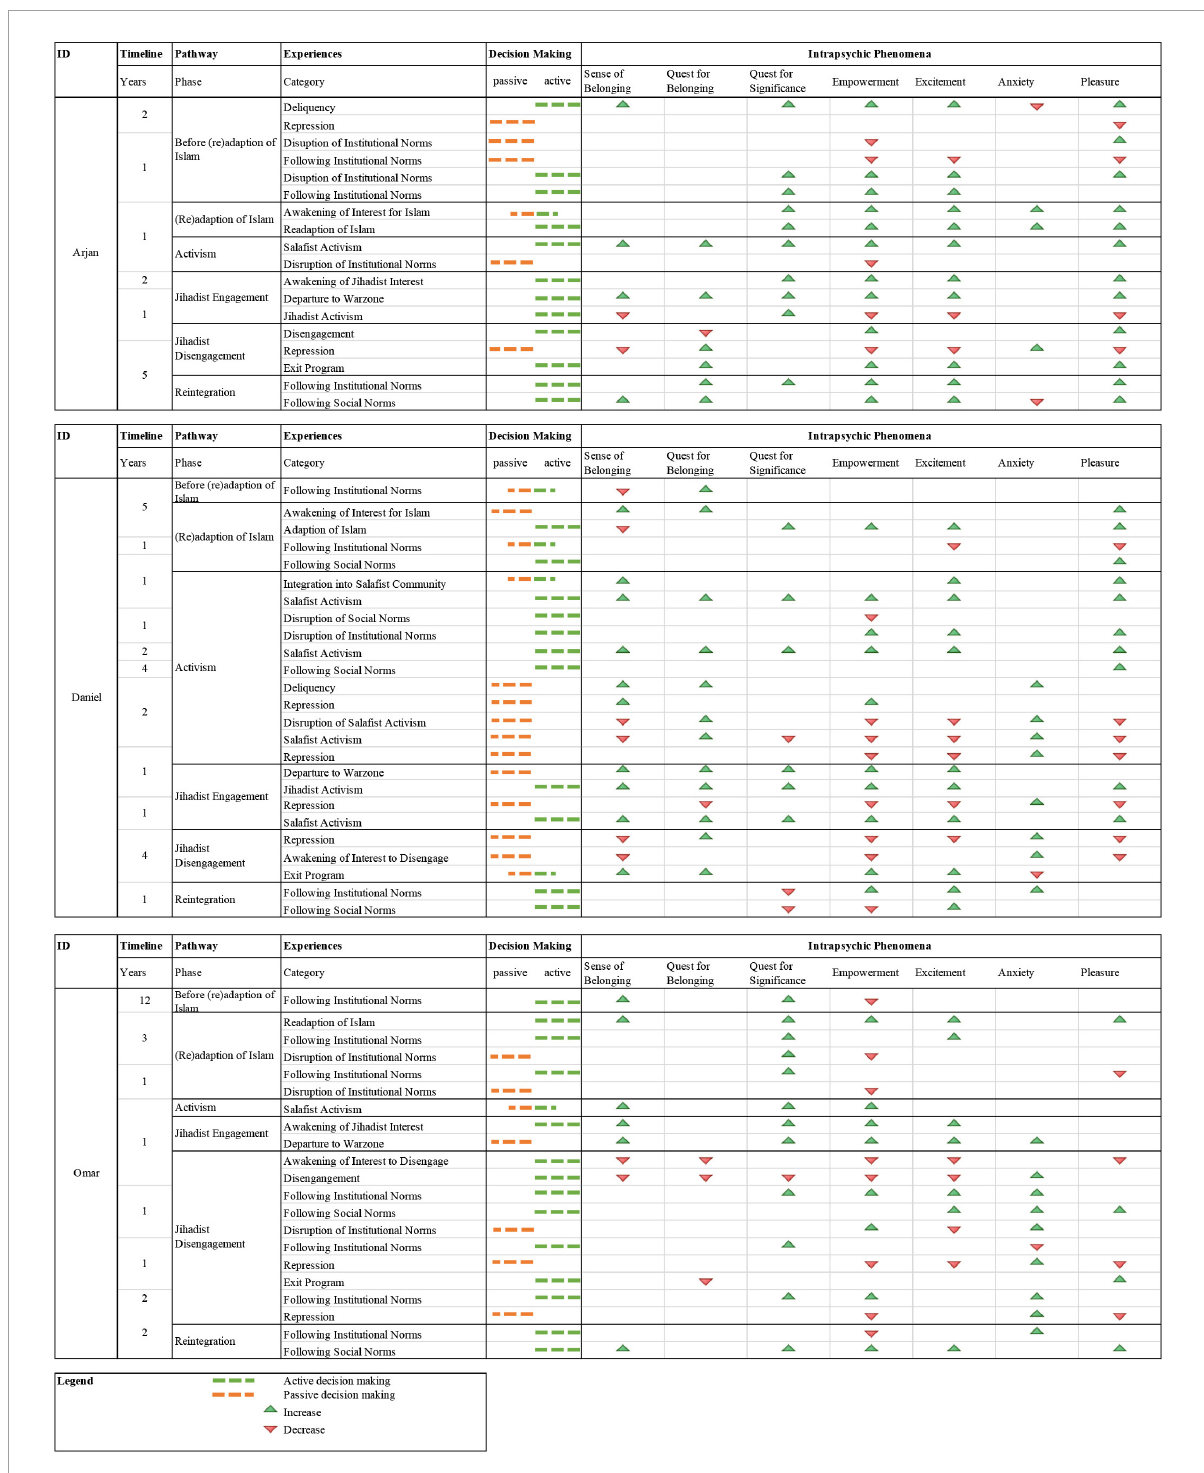
FIGURE1 Multi-methodical case reconstruction of three paradigmatic cases of Salafist jihadist (de)radicalization. Reconstructions are visualized for an overall timeline, pathways of (de)radicalization, clustered biographical experiences, the responsibility for the decision making that led to it, and the relevance of intrapsychic phenomena during those experiences. N = 3; three male convicted homegrown German former